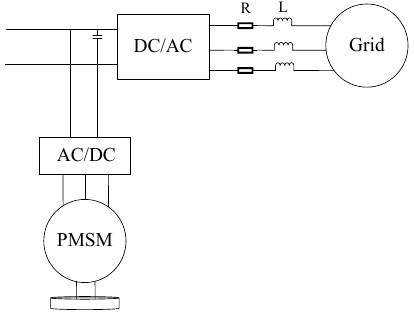
Fig. 11. Grid frequency modulation block diagram based on